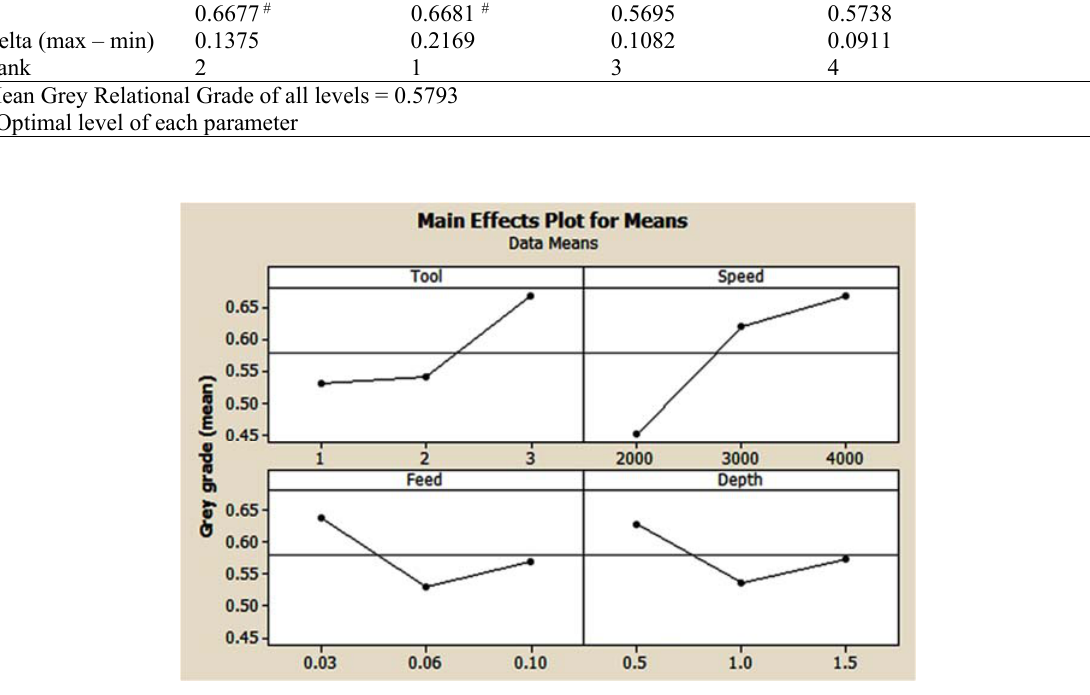
Fig. 8. Main effects chart of the grey relational grade to the levels of the processing parameters.